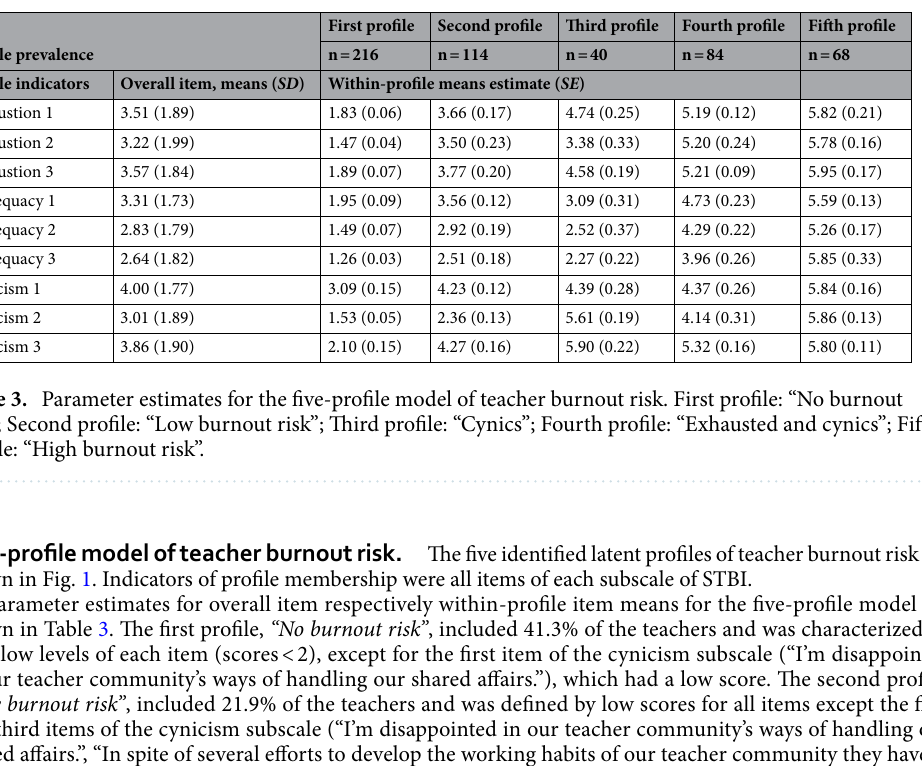
Figure 1. Parameter estimates for the five-profile model of teacher burnout risk and within-profile item means.